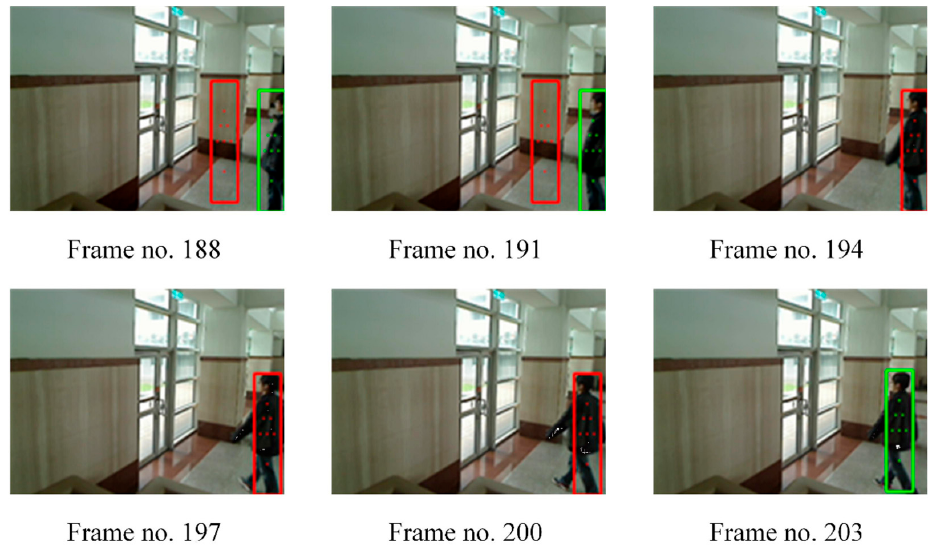
Figure 17. Object2: Frame no. 188~203 from Cam1 in two people tracking scene.